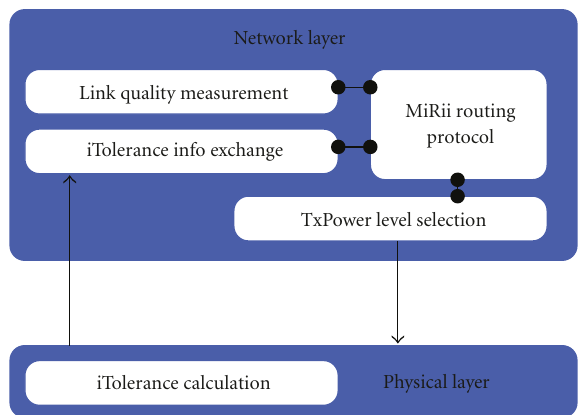
Figure 2: The cross-layer routing protocol